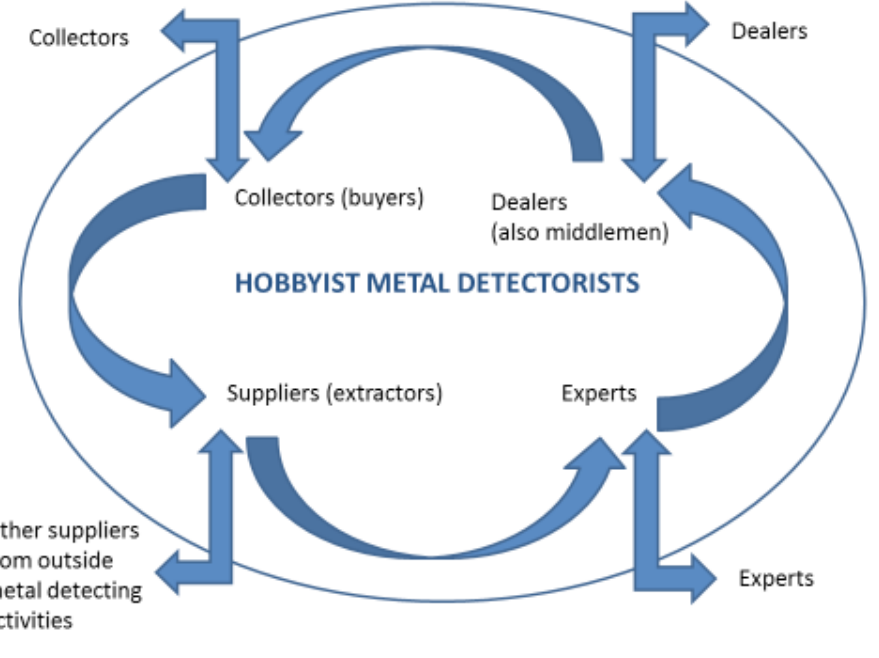
Figure 1: Metal detectorists as multiple-role actors in the trade of cultural objects © Suzie Thomas These multiple external (non-metal detecting) roles may include: collectors of metal-detected and other artefact-hunted material who are not metal detectorists themselves; dealers who buy and sell metal- detected material; experts on finds identification and other particulars from outside of the hobby (e.g. archaeologists, museum curators, or dealers), and other suppliers of connected material which has